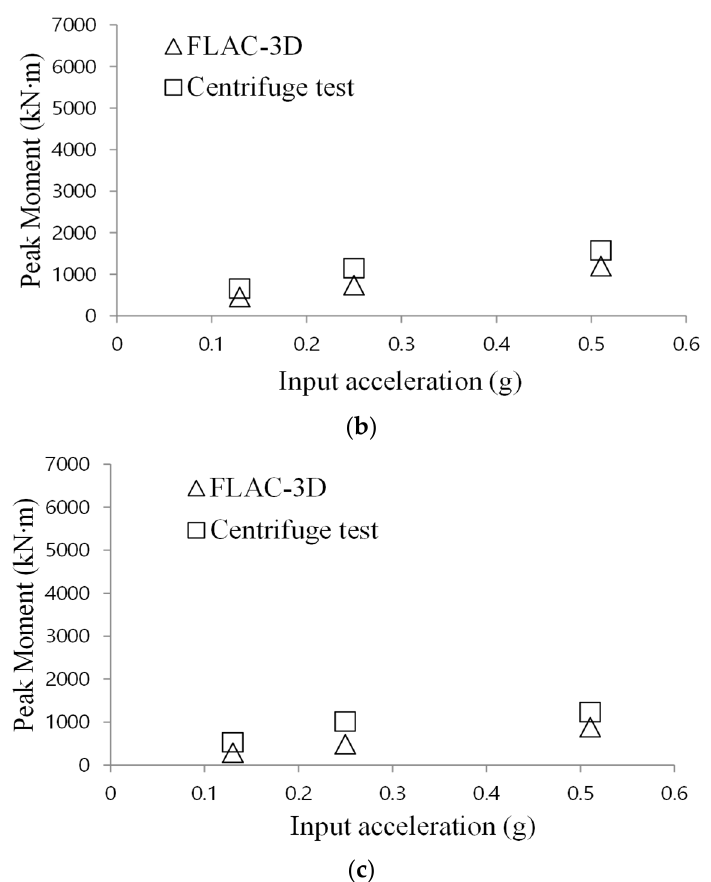
Figure 7. Maximum values of bending moments for various input motions (Model 1, sinusoidal wave):